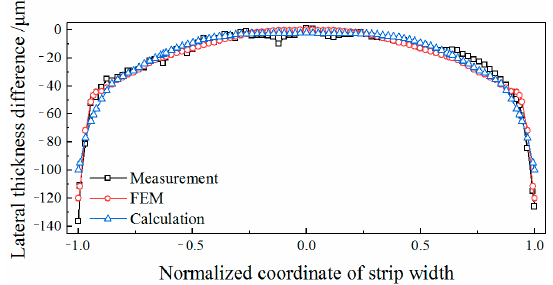
Figure 10. Comparison of the lateral thickness difference.